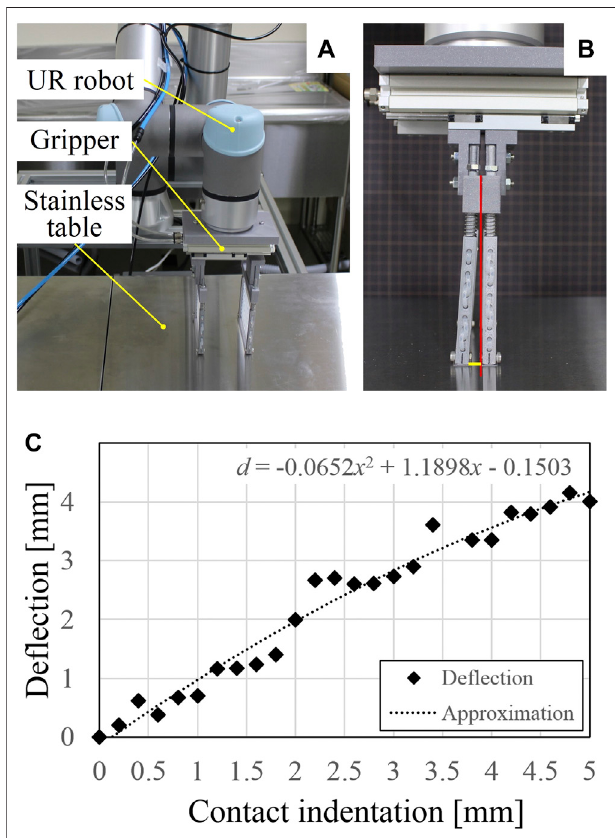
FIGURE 5 | (A) Experimental setup for the contact tests. (B) Example of the bending de fl ection of the rigid rod at an indentation of 5 mm. (C) Relationship between the experimentally measured bending de fl ection and different contact indentations.